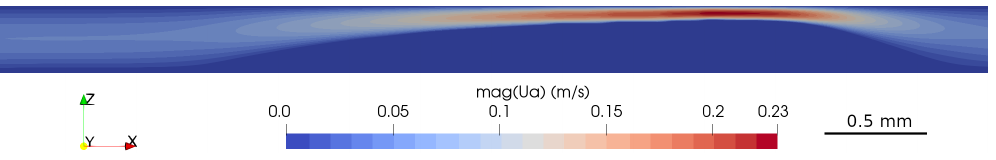
Figure 10. The velocity field of the nanoparticle phase at the third shown state of the aggregate in Figure 9. The aggregated part has nearly zero velocity, while the fluid with the non-aggregated particle phase bypasses it over the narrow passage.